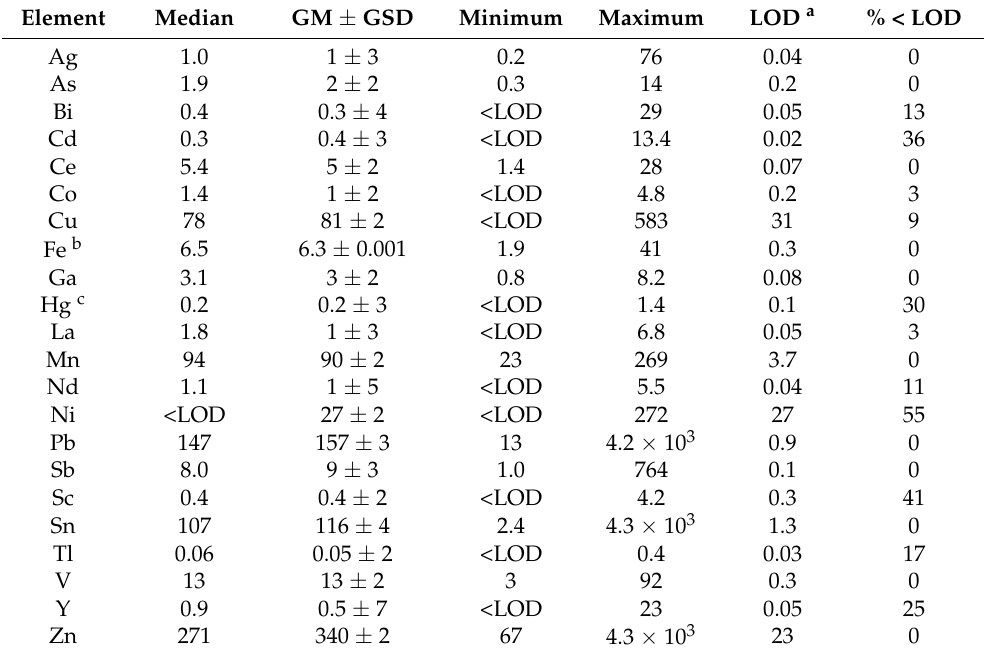
Table 1. Full-shift geometric mean (GM) air concentrations [ng/m 3 ] and geometric standard deviation (GSD) of elements collected among electronic repair workers, ( n =